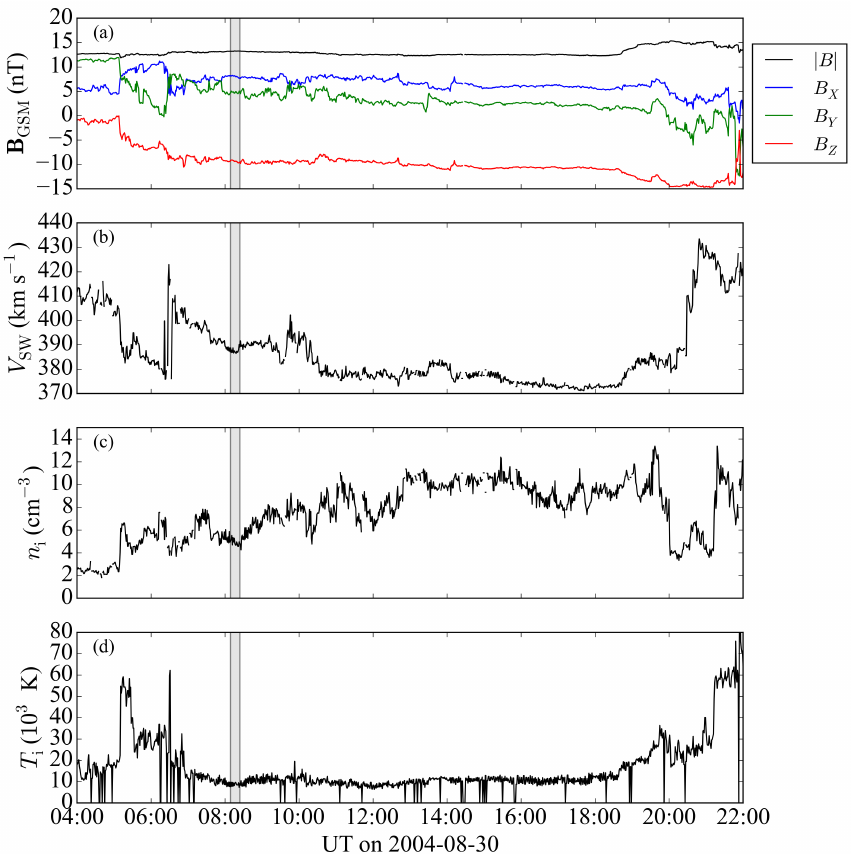
Figure 7. Upstream solar wind observations between 04:00 and 22:00UT on 30 August 2004, from the OMNI dataset with 1min time resolution. (a) Magnetic field. (b) Velocity. (c) Ion number density. (d) Ion temperature. The grey box shows the interval of the event presented in Fig. 11 and Sect.